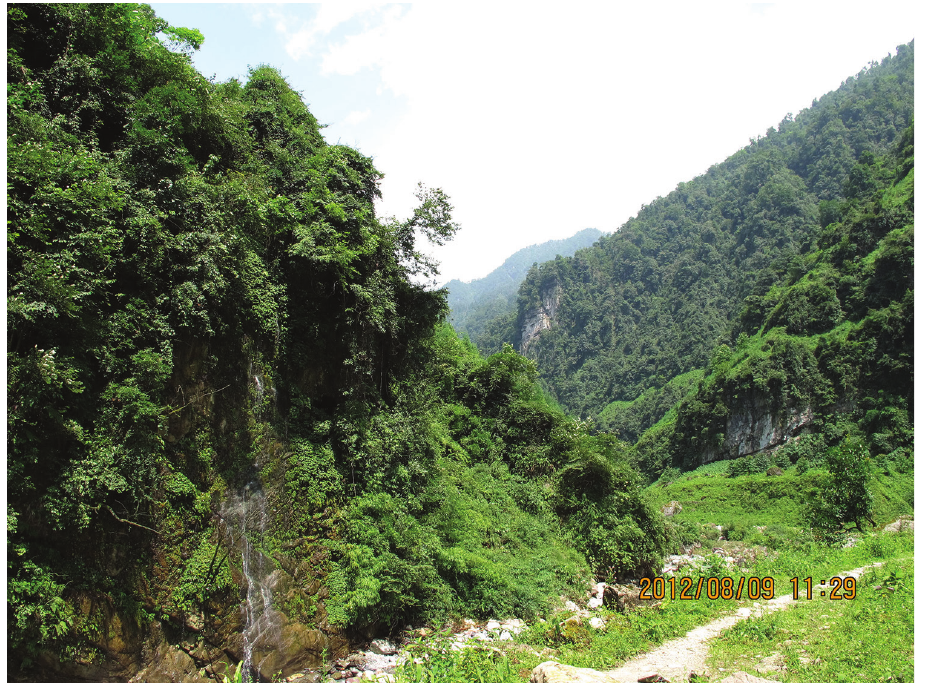
Figure 10. Collecting locality of the specimens treated here (Mabian Dafengding National Nature Re- serve, Sichuan Province,